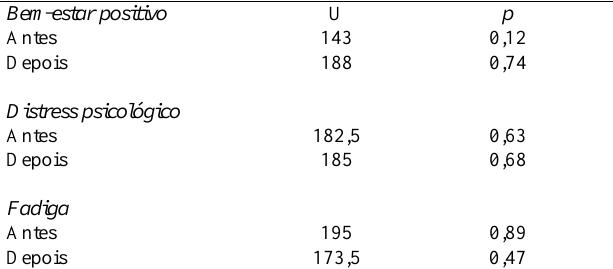
Tabela 4. Resultados do teste Mann-Whitney para cada subescala da SEES comparando o exercício realizado em AR com o realizado em AV